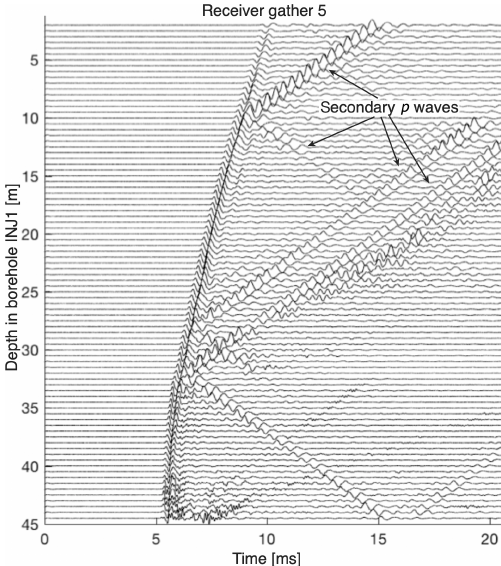
Figure 5. Example seismic data for one receiver and sources in one borehole. Data were recorded using a piezosensor at position 5 (marked in Fig. 3c), and a sparker source was used in borehole INJ1 at 0.5m intervals. The linear features are secondary p waves, cre- ated by tube waves at the intersection with open